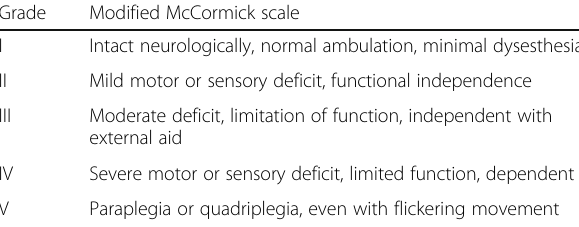
Table 2 Modified McCormick